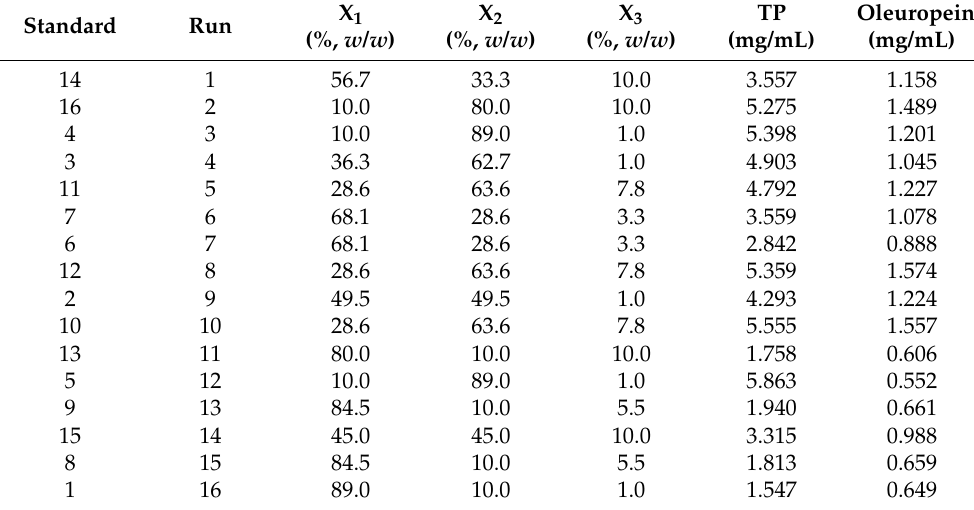
Table 1. Independent variables in the IV-optimal mixture design for magnetic-stirrer-assisted extrac- tion* and content of total phenols (TP) and oleuropein in the extracts. Standard Run